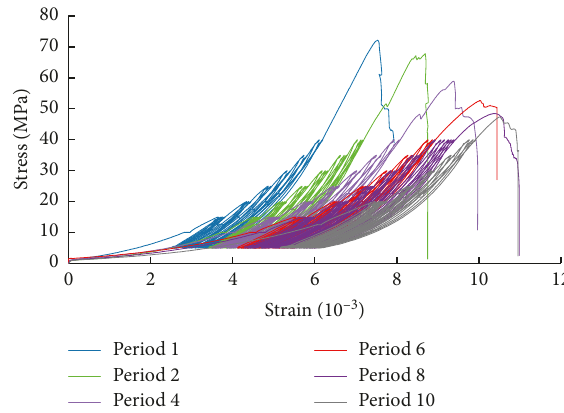
Figure 4: Typical rock sample stress-strain curve for cycle loading and unloading.